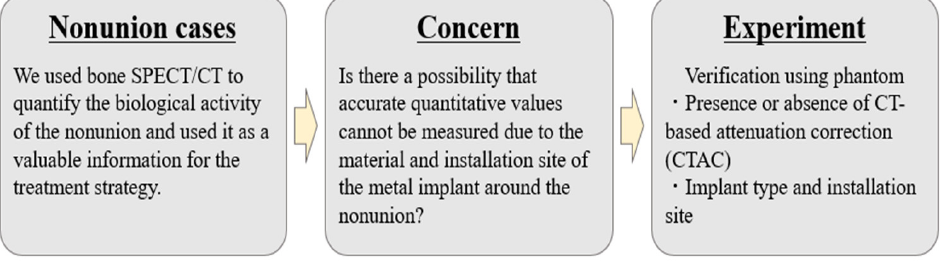
Figure 1. Comprehensive schema of research.